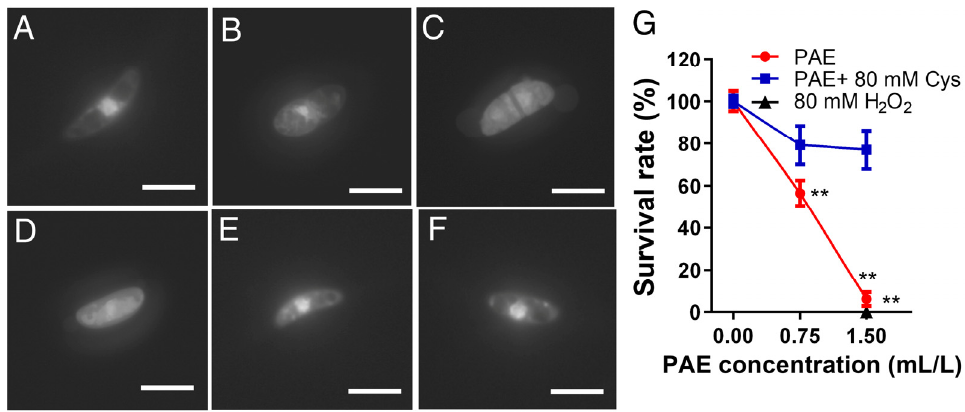
Figure 7. Effect of PAE on nuclear morphometry measured by DAPI staining. Spores were exposed to 0.75 ( B ) and 1.5 ( C ) mL/L PAE, 80 mM H 2 O 2 ( D ), and to 0.75 ( E ) or 1.5 ( F ) mL/L PAE plus 80 mM Cys for 12 h. Spores without PAE treatment were served as control ( A ). Bar = 50 μ m. Line chart of survival rate of spores in every experimental group ( G ). Values are mean ± standard deviations ( n = 3). ** indicates p < 0.01 compared with the control group calculated by one-way ANOVA.